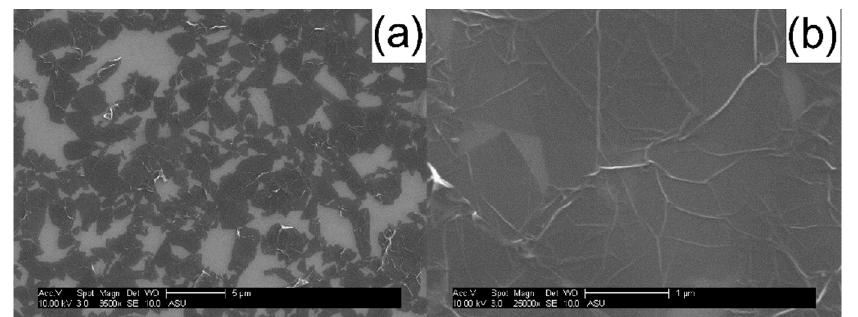
Figure 5. (a) Low magnification and (b) high magnification of SEM images of mRGO-180 LB film Figure 5. ( a ) Low magnification and ( b ) high magnification of SEM images of mRGO-180 LB film on on Si wafer. Si